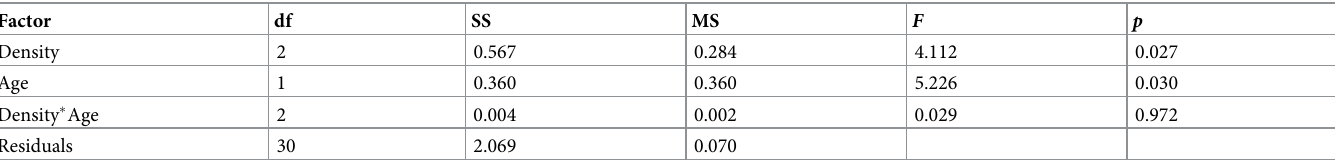
Recaptures in McPhail traps were heavily female biased (Tables 2 and 3). Analysis of female recaptures via a second ANOVA tested the effect of application density, MAT grid age, plot location, and their full interaction. It did not show any significant effects ( p > 0.05). The Table 4. ANOVA of log(number estimated killed) as predicted by application density, grid age, and their interaction. Log transformed response variable was used to ensure homogeneity of variances as assessed via Bartlett’s test. Factor df